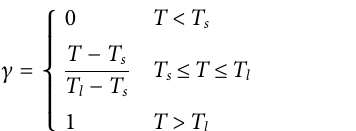
Frontiers in Energy Research |